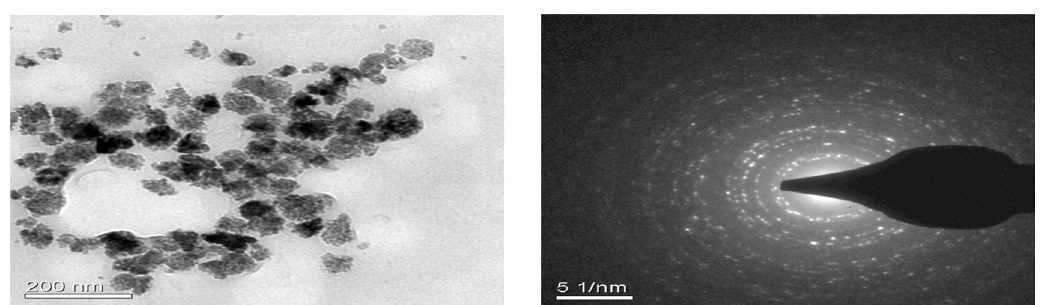
Fig. 8. (A) TEM image of biosynthesized ZnONPs. (B) SAED pattern of biosynthesized ZnONPs.